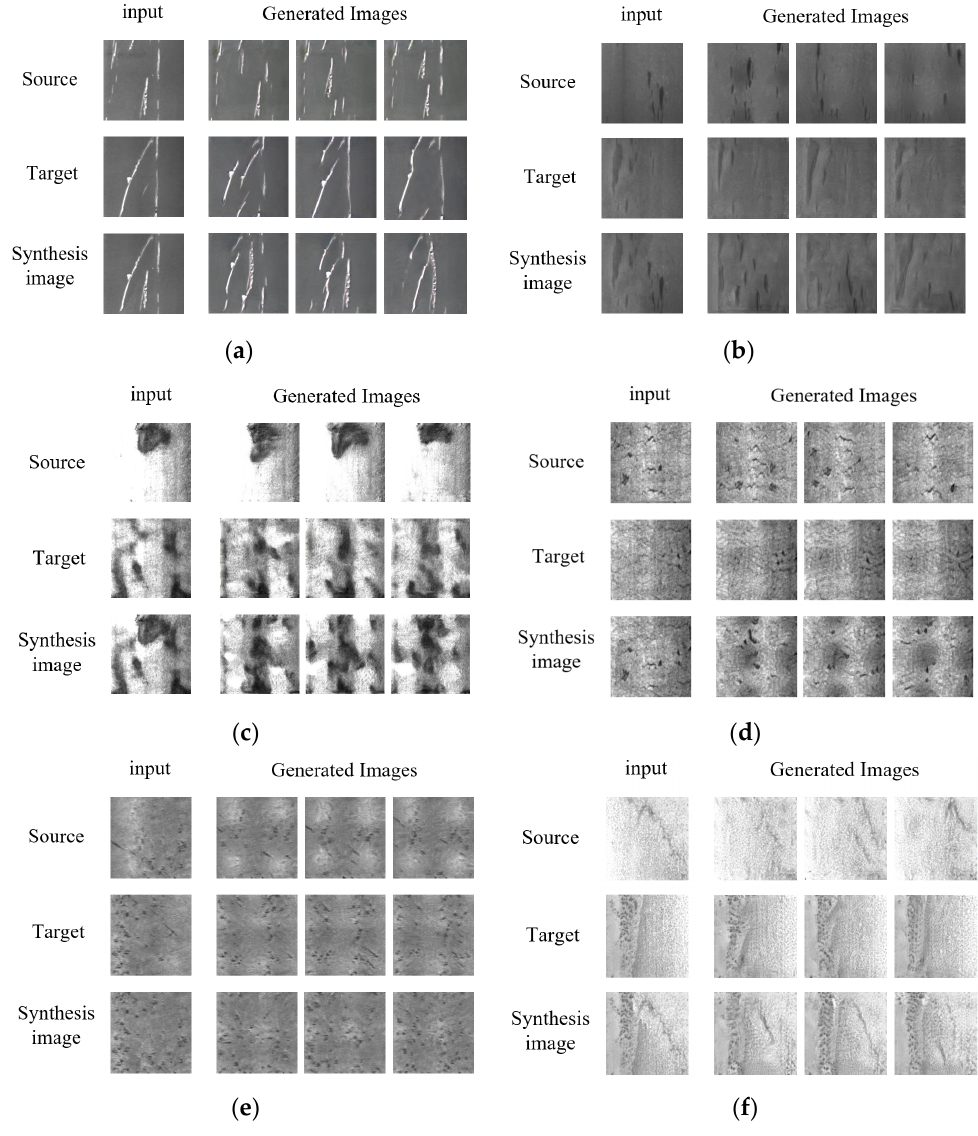
Figure 13. Defect image generated via image synthesis. ( a ) Sc. ( b ) In. ( c ) Pa. ( d ) Cr. ( e ) Rs. ( f ) PS.